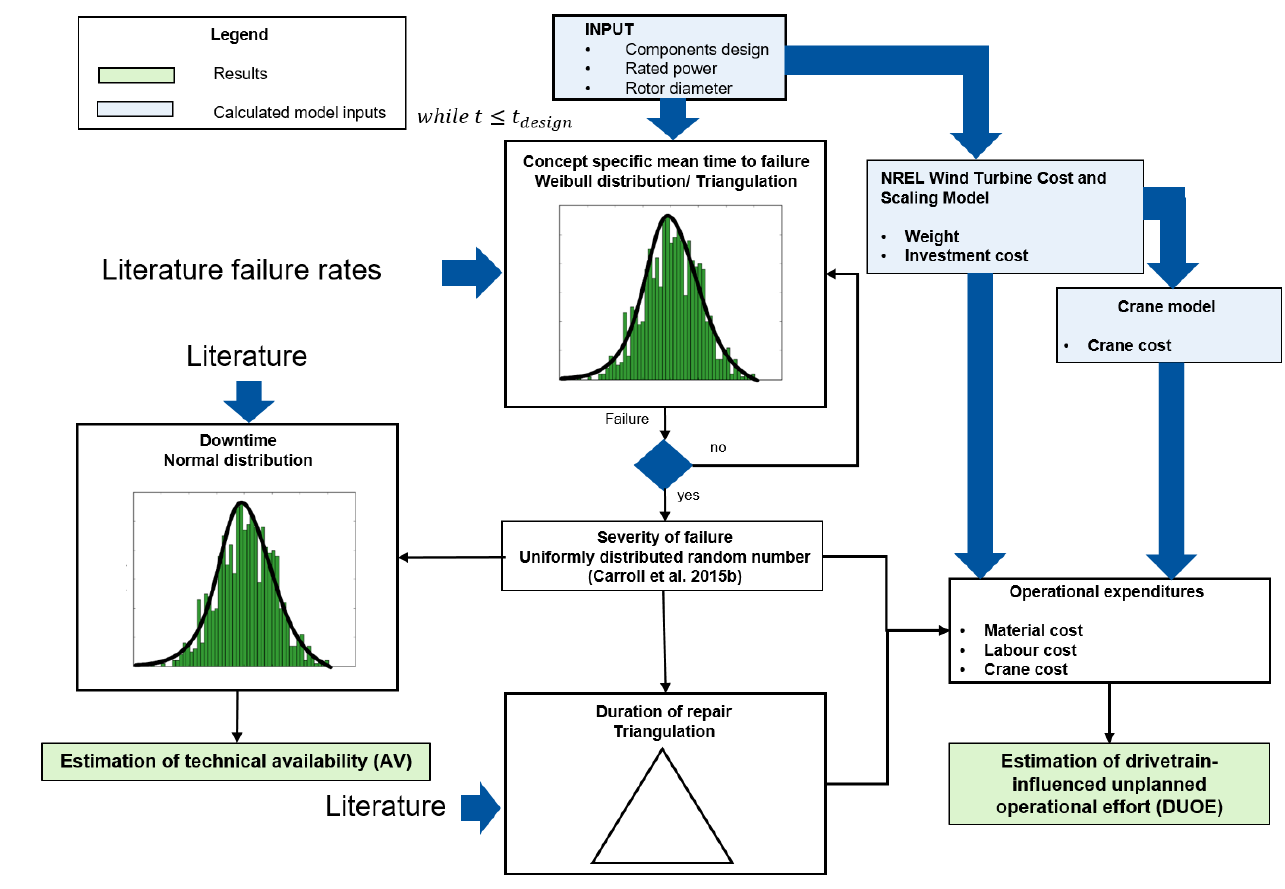
Figure 2. Overview of model structure.